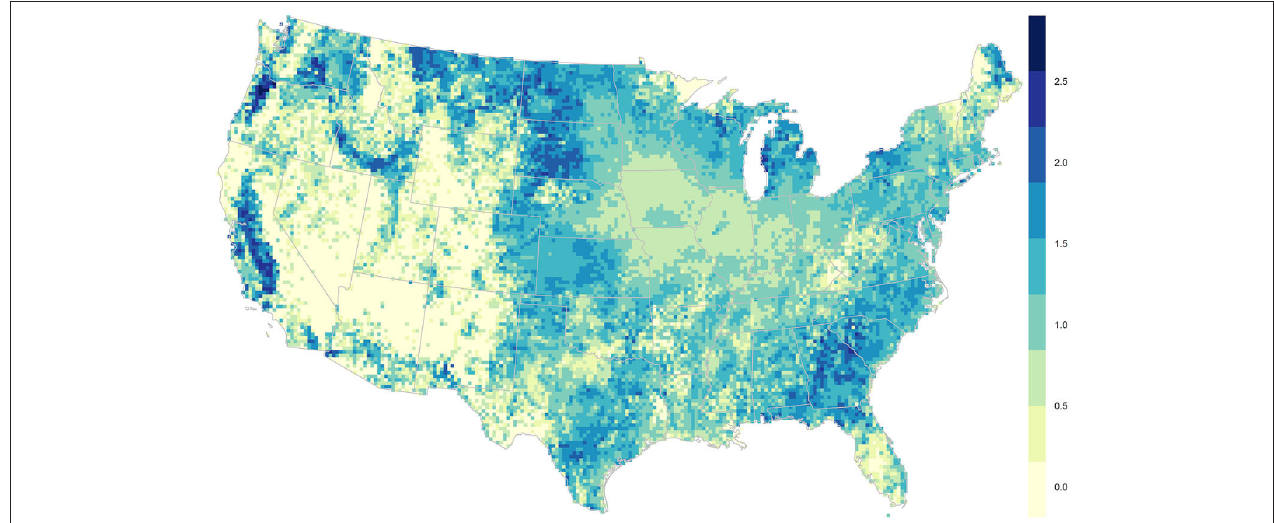
FIGURE 10 | Shannon’s Diversity Index (SDI) of agricultural land use categories for each 20-km pixel in the U.S. in 2017. Light green indicates counties with a low SDI and dark blue indicates counties with a high SDI. Reprinted from Burchfield et al. (2019). Copyright (2019), with permission from